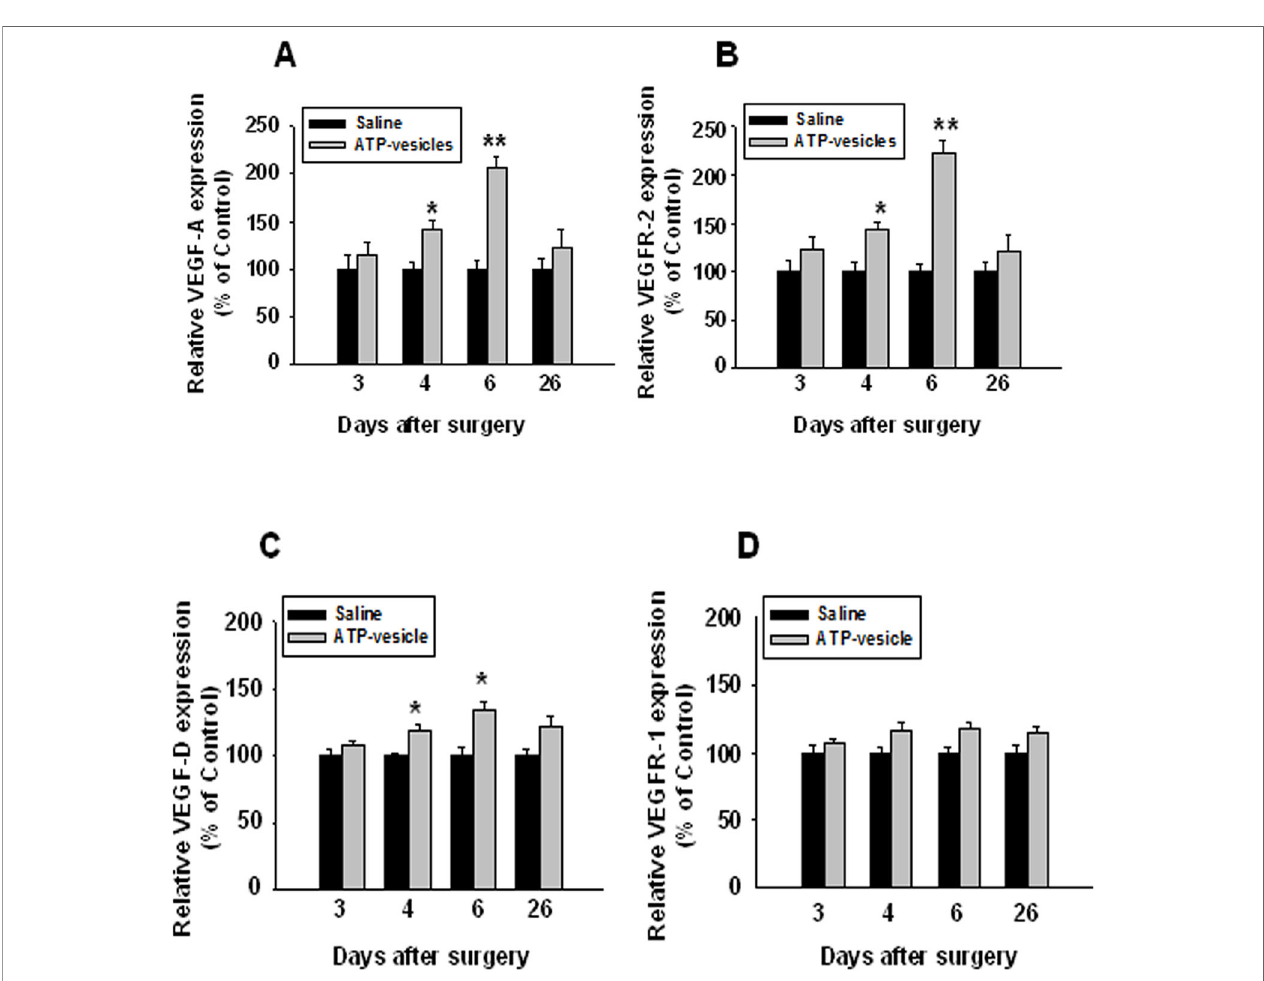
FIGURE 7 | Immunohistochemical staining of VEGFs and their receptors in ATP-vesicle-treated and saline-treated wounds. The number of positively stained cells and total cells per high power microscopic fi eld were counted. The increased expressions of VEGF-A, VEGF-D, and VEGFR-2 were clearly seen in ATP-vesicle- treated than saline-treated wounds (A , B and C) , but the increase of VEGFR-1 was not statistically signi fi cant (D) . The expression level of VEGFs and their receptors in each sample was expressed as a percentage of the total number of cells that are positively stained. The relative expression levels in ATP-vesicle-treated wounds was normalized to that of normal saline-treated wounds at the same time point. Data shown are the mean ± SD of four to six different wound samples, with at least 5 fi elds for each sample. Signi fi cant difference as compared to that of normal saline-treated group, *p < 0.05; **p <